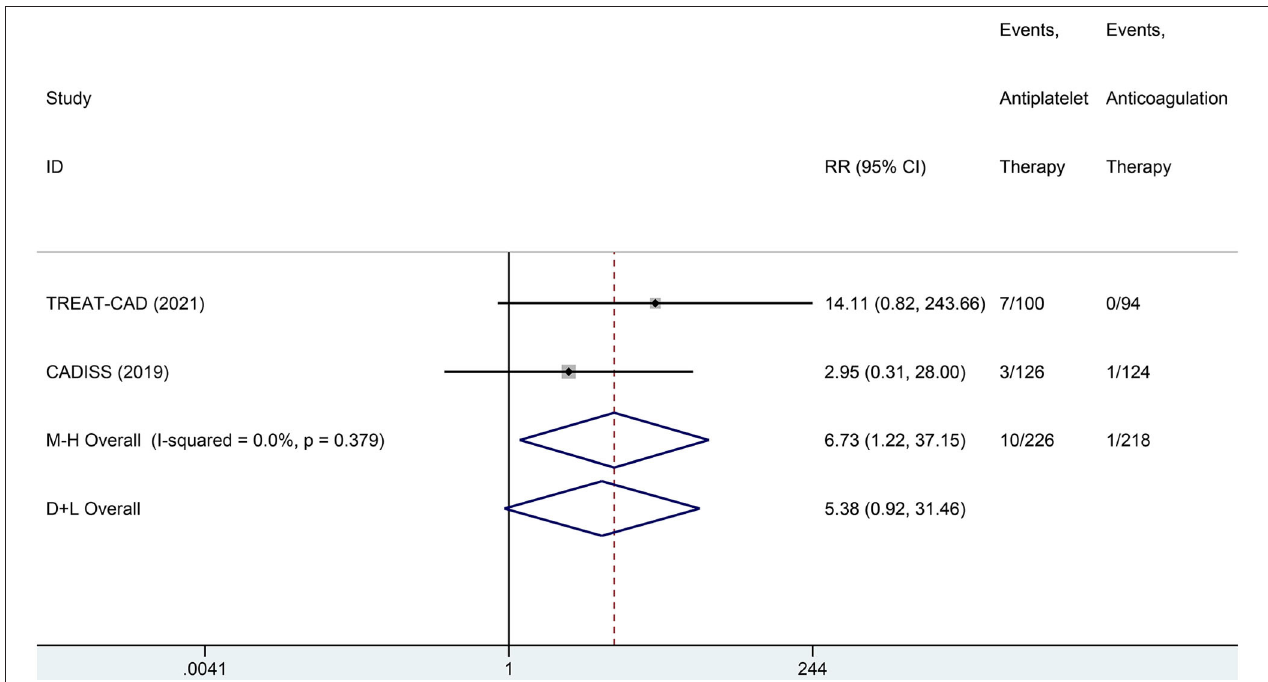
FIGURE 3 | A forest plot of comparison for ischemic stroke between the antiplatelet and anticoagulation in the intention-to-treat (ITT) population.